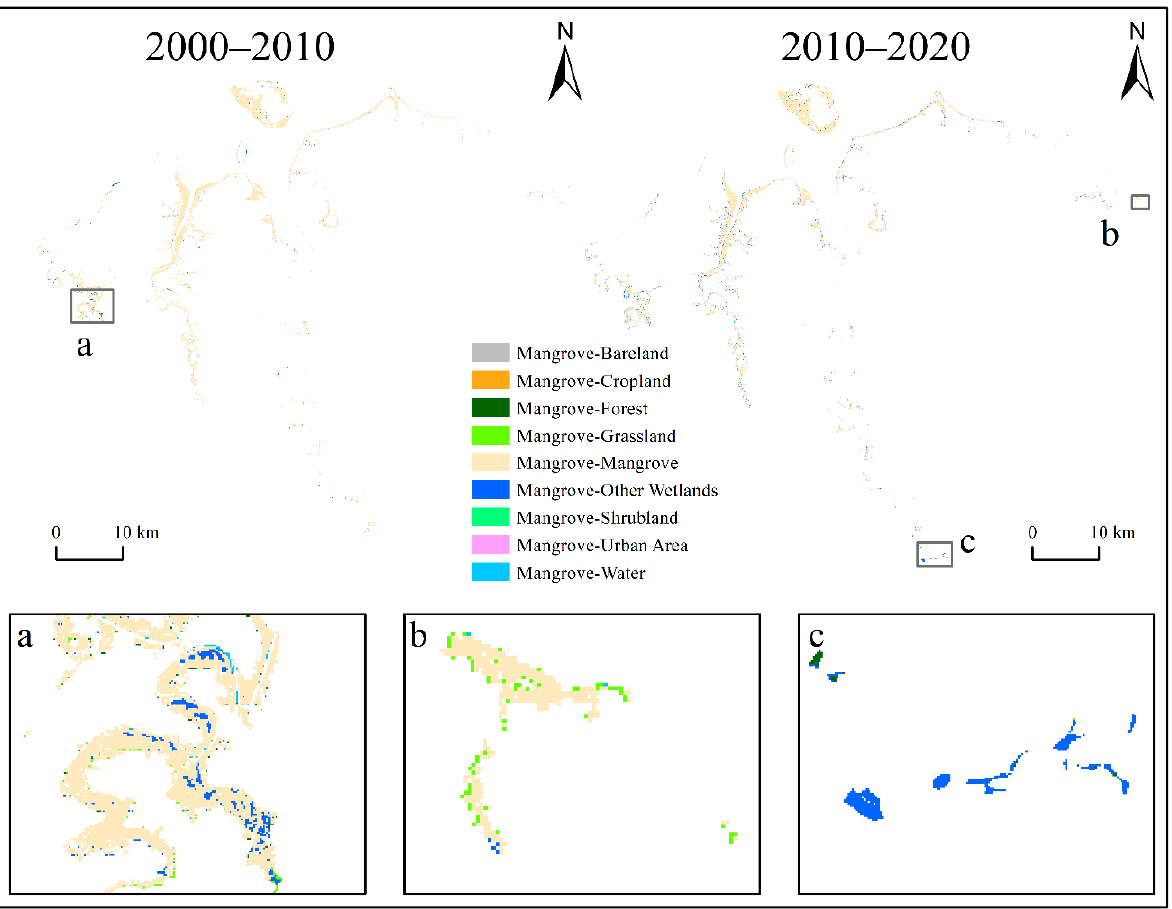
Figure 12. Maps of spatial–temporal distribution of mangrove degradation in Kakadu NP from 2000 to 2020. ( a ) first degradation detail picture; ( b ) second degradation detail picture; ( c ) third degradation detail picture.